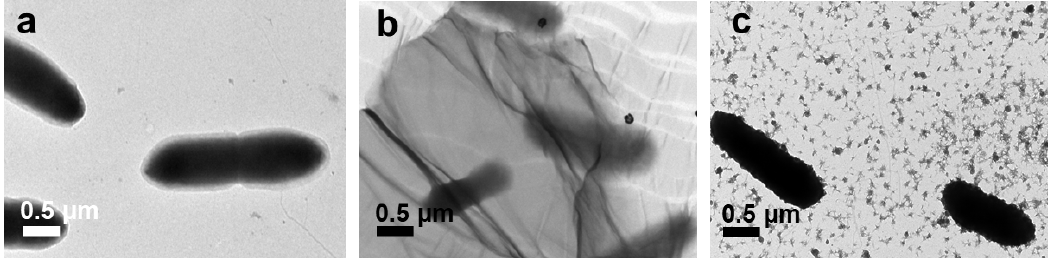
Figure 9. TEM images of the E. coli control cells ( a ) and cells treated with >1 µm ( b ) and ~100 nm ( c ) GO.